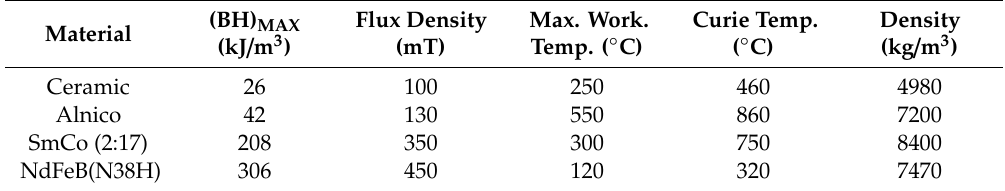
Table 5. Properties of some common magnetic material.